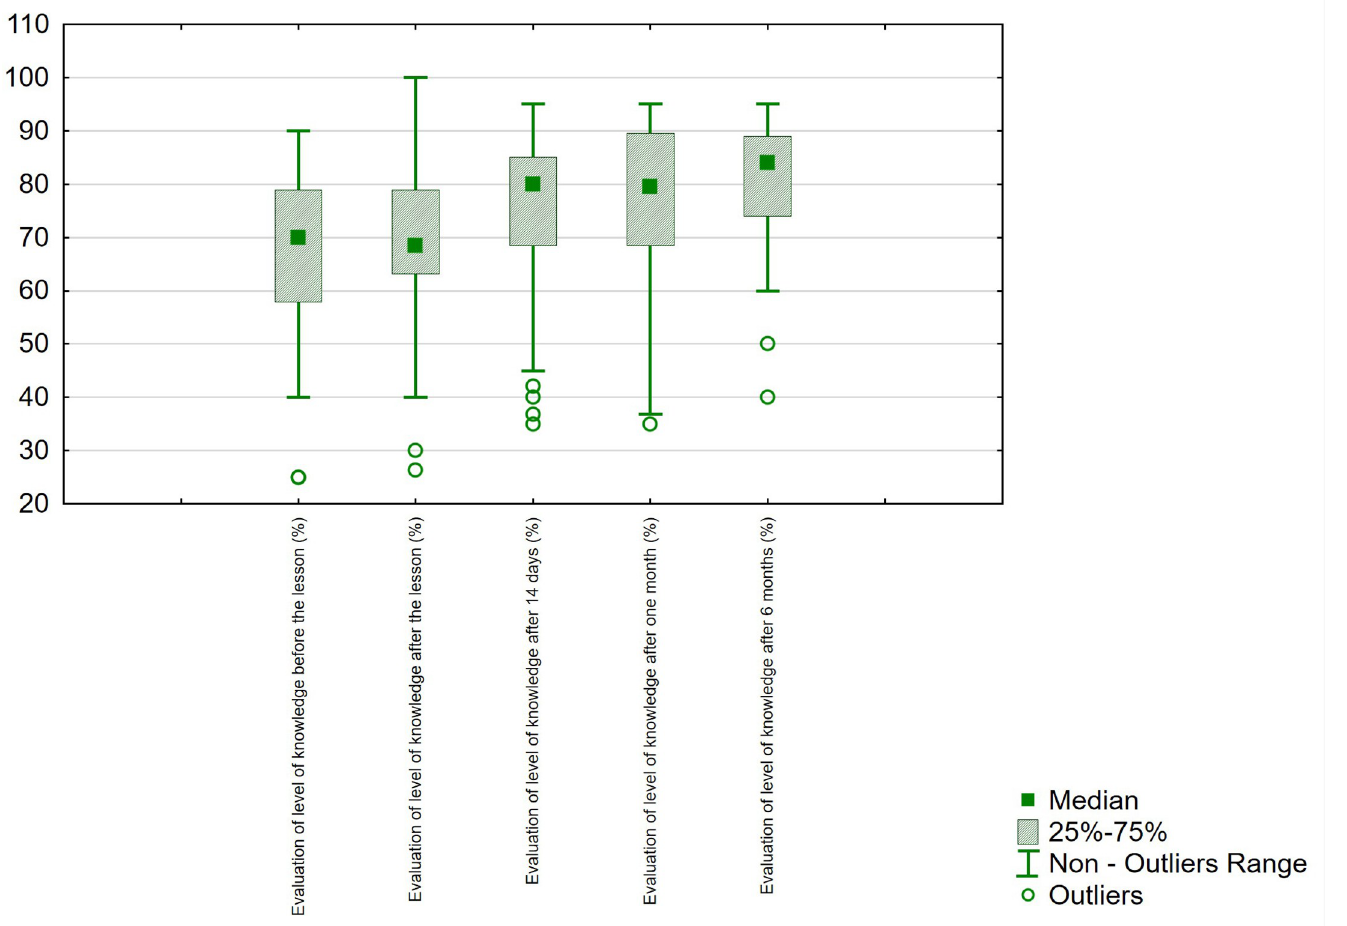
Fig 2. The level and distribution of knowledge of students, who participated in farm education, in time.